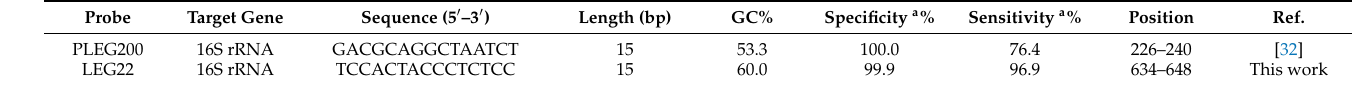
Table 2. Evaluation of the Legionella spp. PNA probes available.